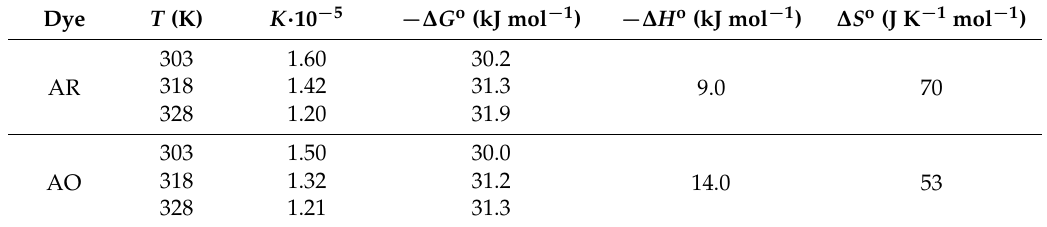
Table 5. Thermodynamical parameters of adsorption of anionic dyes on